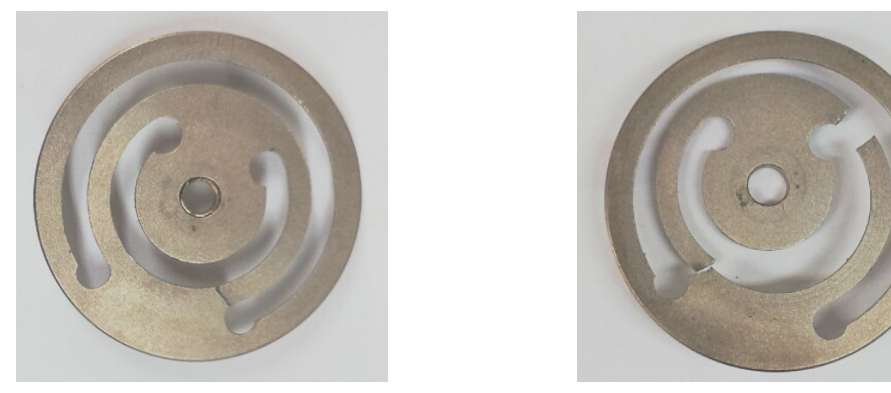
Figure 2. Broken metal springs during high ‐ speed train test [41].